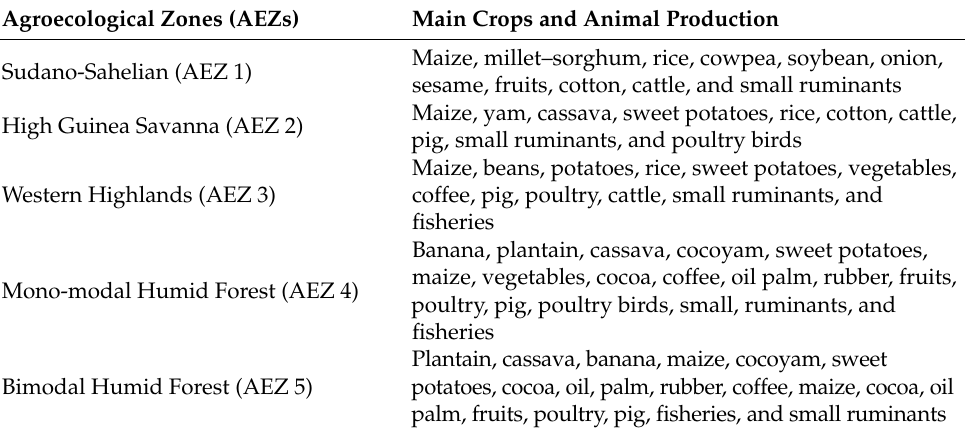
Table 1. Major crops cultivated and animal species reared in each agroecological zone. Agroecological Zones